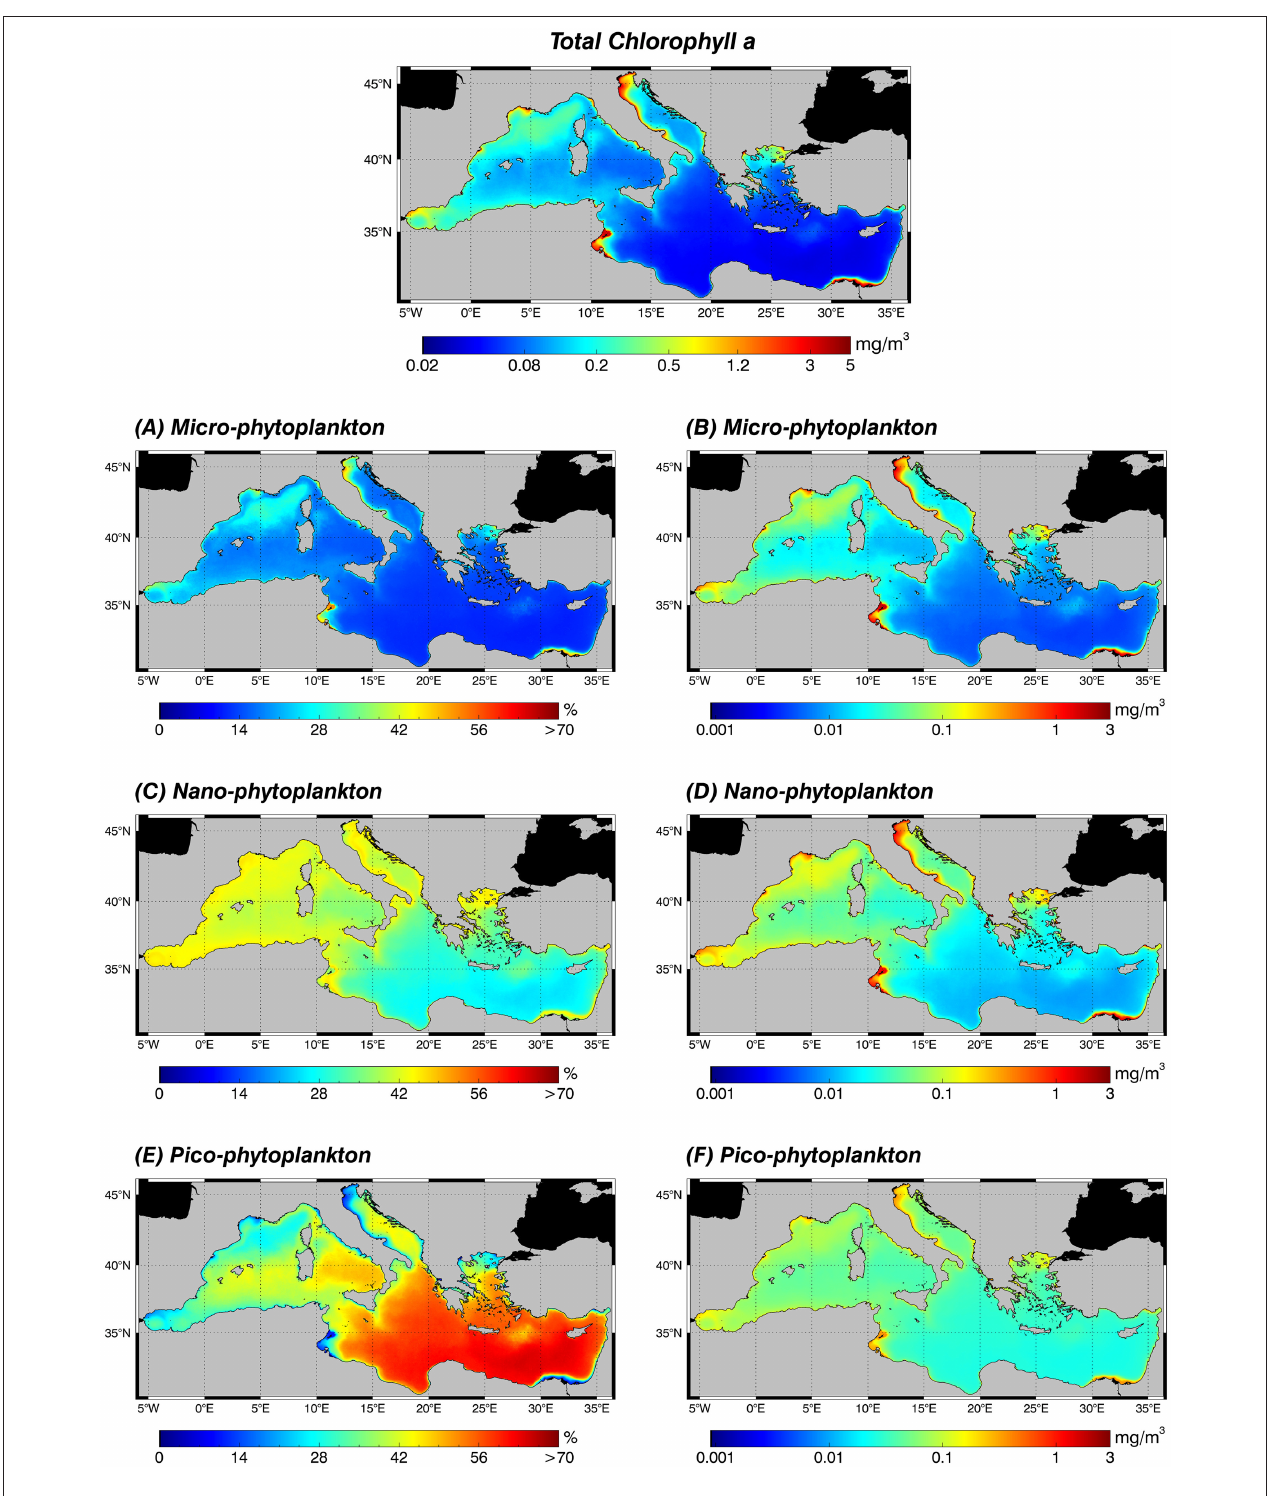
FIGURE 5 | Annual climatological maps (1998–2015) of the TChl a (top panel) and the PSCs: for each pixel, fractions are expressed in % with respect to the TChl a (left panel: A,C,E) and the contribution of each PSC group to the TChl a concentration in mg m − 3 (right panel: B,D,F ). PSCs are retrieved applying the new regional algorithms (see Table 4 ) on the daily TChl a times series (Mediterranean reprocessed product produced by the CMEMS-OCTAC). (A,B) Micro-phytoplankton, (C,D) Nano-phytoplankton, (E,F) Pico-phytoplankton.